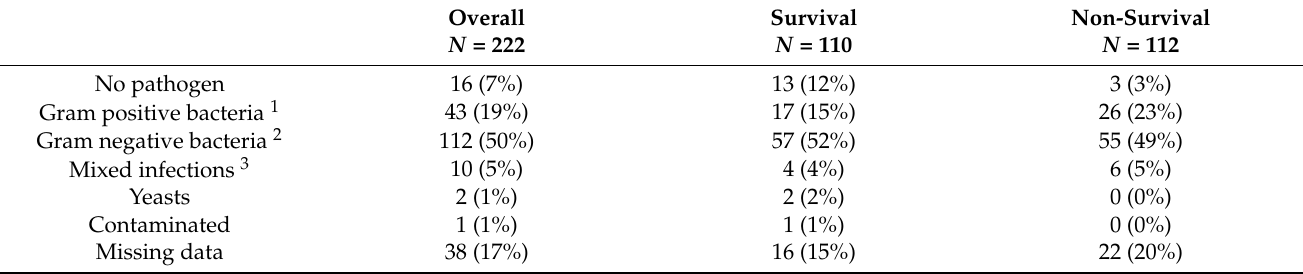
Table 3. Descriptive statistics (overall and stratified by survival status) of milk bacteriology data from dairy cows (124 herds) affected by severe clinical mastitis in Qu é bec,